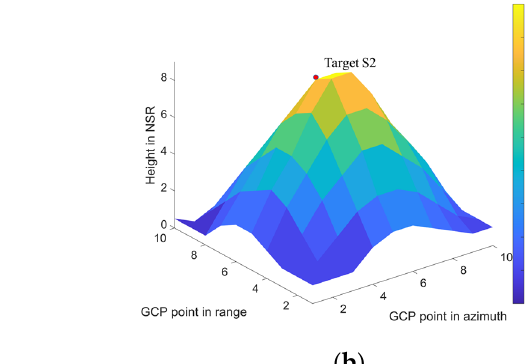
Figure 14. The 3D imaging results in cone scene: ( a ) baseline number 20; ( b ) baseline number 10.